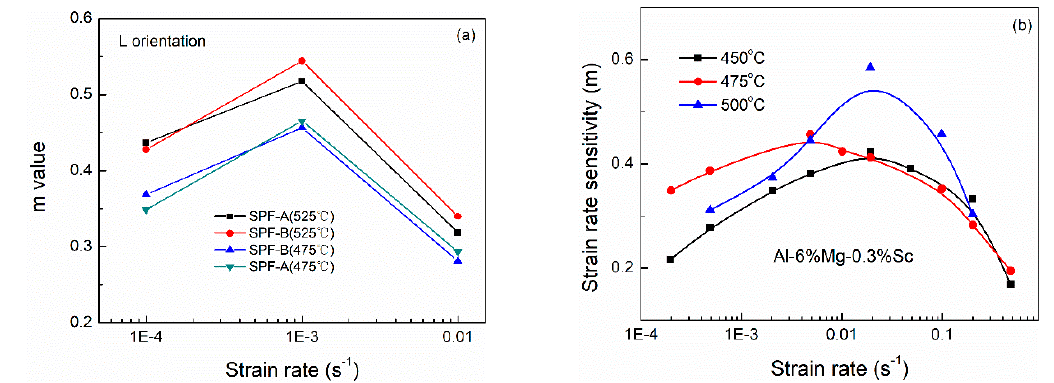
Figure 6. ( a ) Relation between strain rate sensitivity and strain rate for Superplastic Forming (SPF) 5083 alloys in longitudinal orientation, reproduced from [91], with permission from Springer Nature, 2004; ( b ) variation of strain rate sensitivity at different temperatures and strain rates for the Al-6Mg-0.3Sc alloy, reproduced from [70], with permission from Elsevier, 1998.